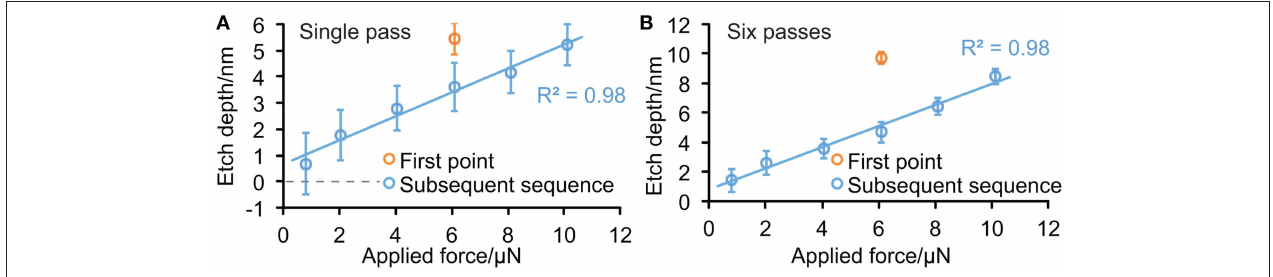
FIGURE 3 | Wear-in process for diamond-coated probe on 2 µ m × 2 µ m areas of SiO x . (A,B) Etch depth for single and sets of six etching passes, respectively. At each force, firstly a single pass was made at one location, followed by a set of six passes at a new location (i.e., cycling between A,B ). In each case, the first data point (orange circles) produces the deepest trench. Subsequently, measurements were made with increasing force from around 1 to 10 µ N, producing a linear